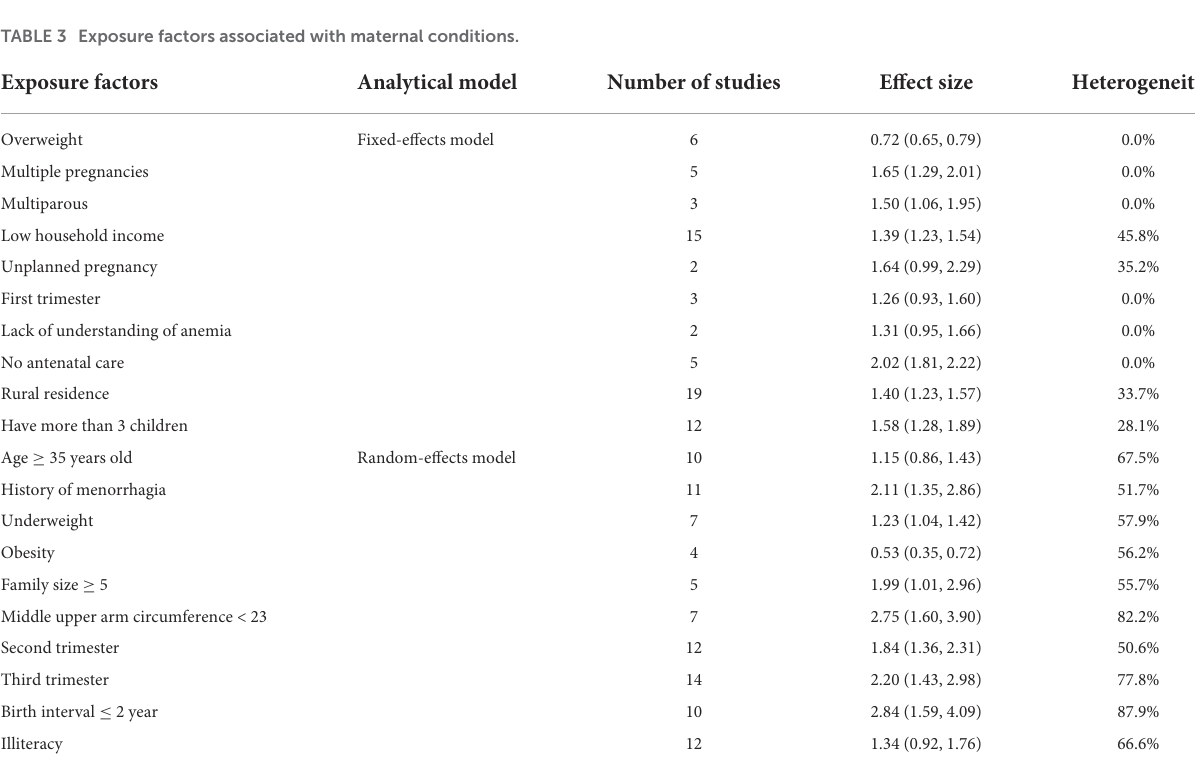
TABLE 3 Exposure factors associated with maternal